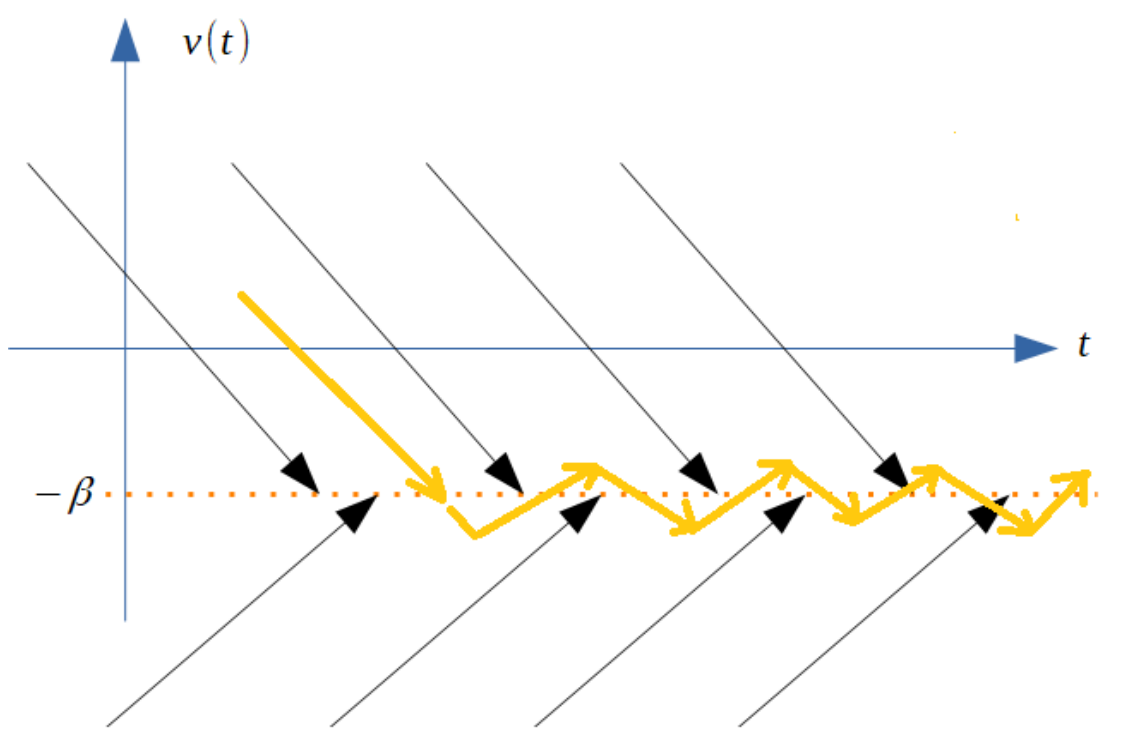
Figure 17. In a yellow line: A realistic trajectory of the closed-loop system (3) presenting chattering.